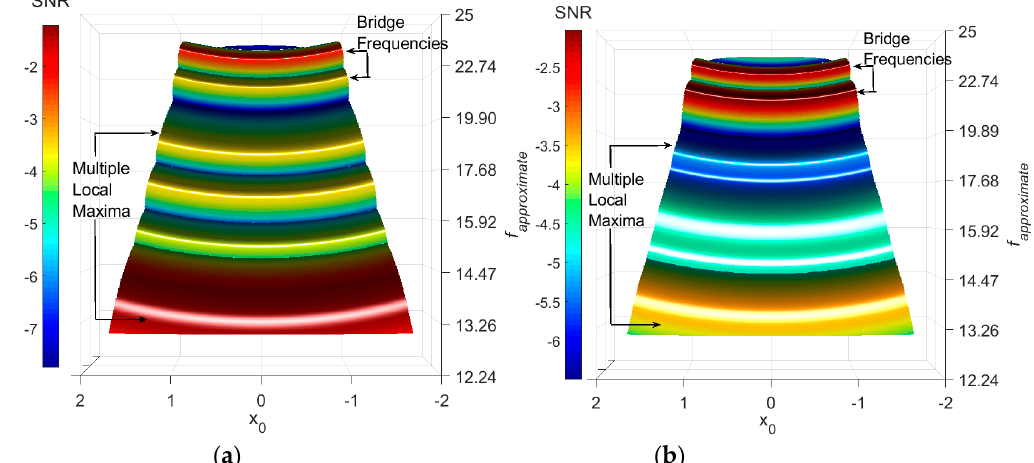
Figure 13. SNR-Surface plot for road profile Class “A” with ( a ) 2.5-cm increment ( b ) 25-cm increment.